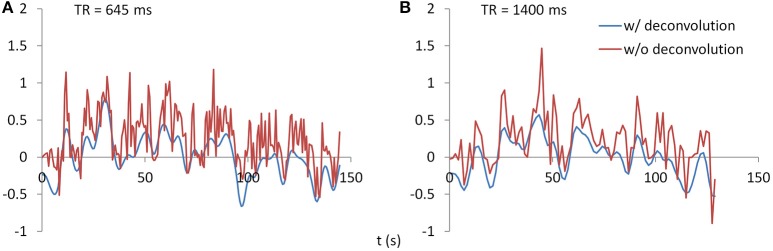
Examples of PPI terms calculated by the deconvolution and non-deconvolution methods for the two TR runs.